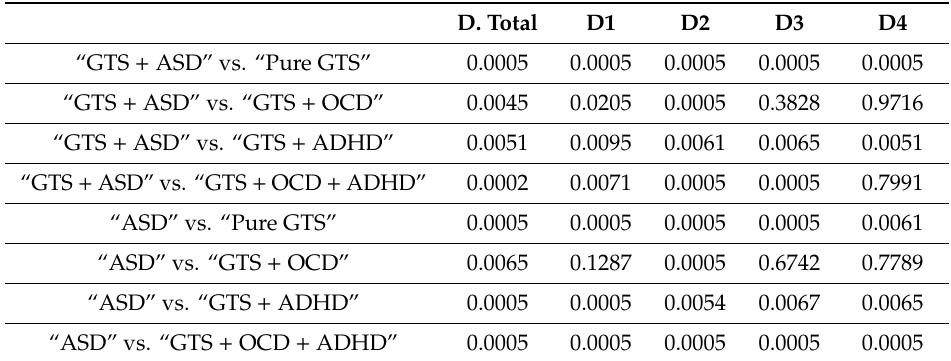
Figure 4. ADOS (D scale) restricted and repetitive behaviors: comparison between clinical sub-phenotypes. GTS: Gilles de la Tourette Syndrome; ASD: Autism Spectrum Disorder; OCD: Obsessive–Compulsive Disorder; ADHD: Attention Deficit Hyperactivity Disorder. Table 4. ADOS Restricted and repetitive behaviors (D Scale): statistical significance in comparison with clinical sub-phenotypes.